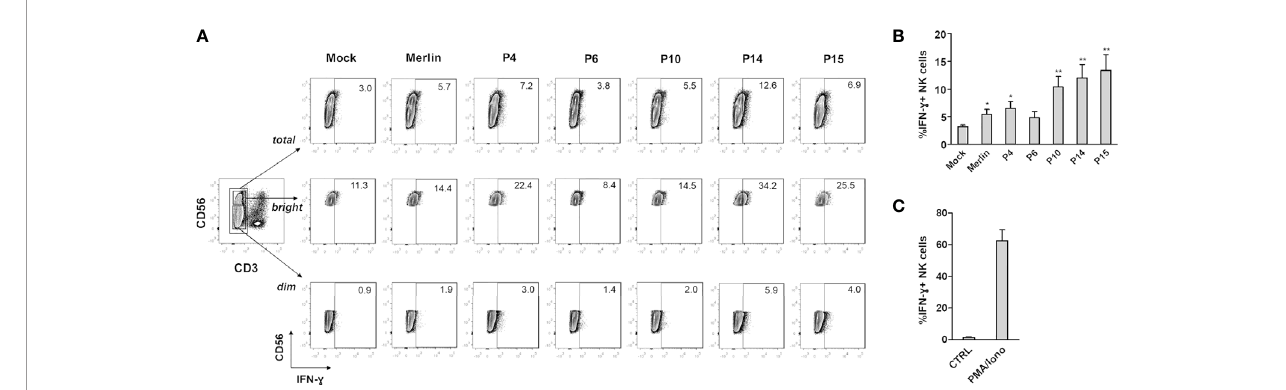
FIGURE 2 | IFN- g expression in NK cells co-cultured with HCMV-infected HFFs. NK cells were co-cultured with mock- or HCMV-infected HFFs at day 2 post infection, as described in Materials and Methods. The day after, NK cells were harvested and stained for intracellular IFN- g . (A) A representative experiment of at least four performed with all HCMV isolates is shown. Numbers indicate the percentage of IFN- g + cells in the gate of CD3-CD56 + (total), CD3-CD56dim (dim), or CD3- CD56bright (bright) NK cells. All cells were fi rst gated among viable (Zombie-) population. (B) Cells were analyzed as in panel (A) , and data are expressed as the mean percentage (%) ± SE of IFN- g + cells in the gate of total CD3-CD56 + NK cells. Data are from at least four independent experiments (* P < 0.05; ** P < 0.01 paired Student t test for comparison of infected vs. mock cells). (C) Negative (ctrl) and positive (PMA/iono) controls for IFN- g production are also shown, and are referred to NK cells cultured alone or in the presence of PMA plus